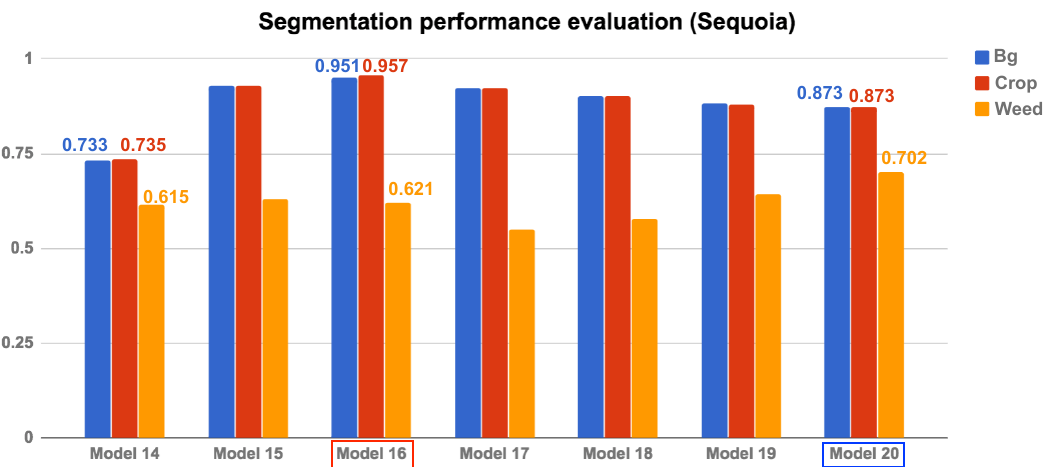
Figure 11. Quantitative evaluation of the segmentation using area under the curve (AUC) of the Sequoia dataset. As in the RedEdge-M dataset, the red box indicates the best model, and the blue box is a model with only one NDVI image